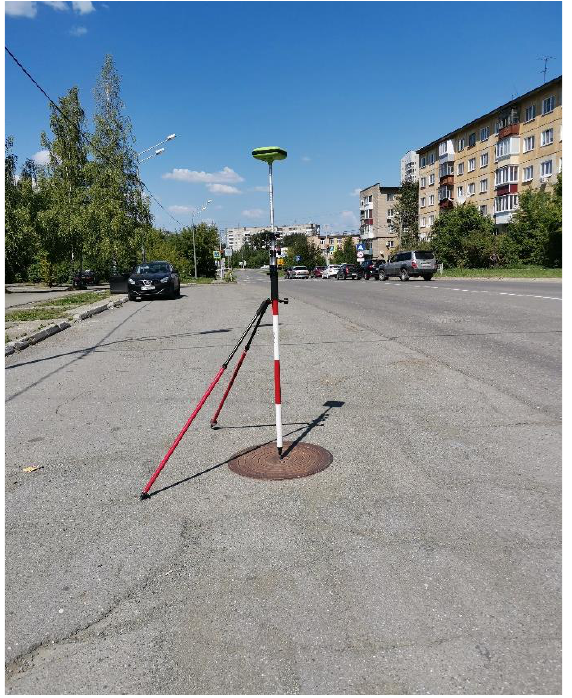
Figure 5 . An example of a check point.